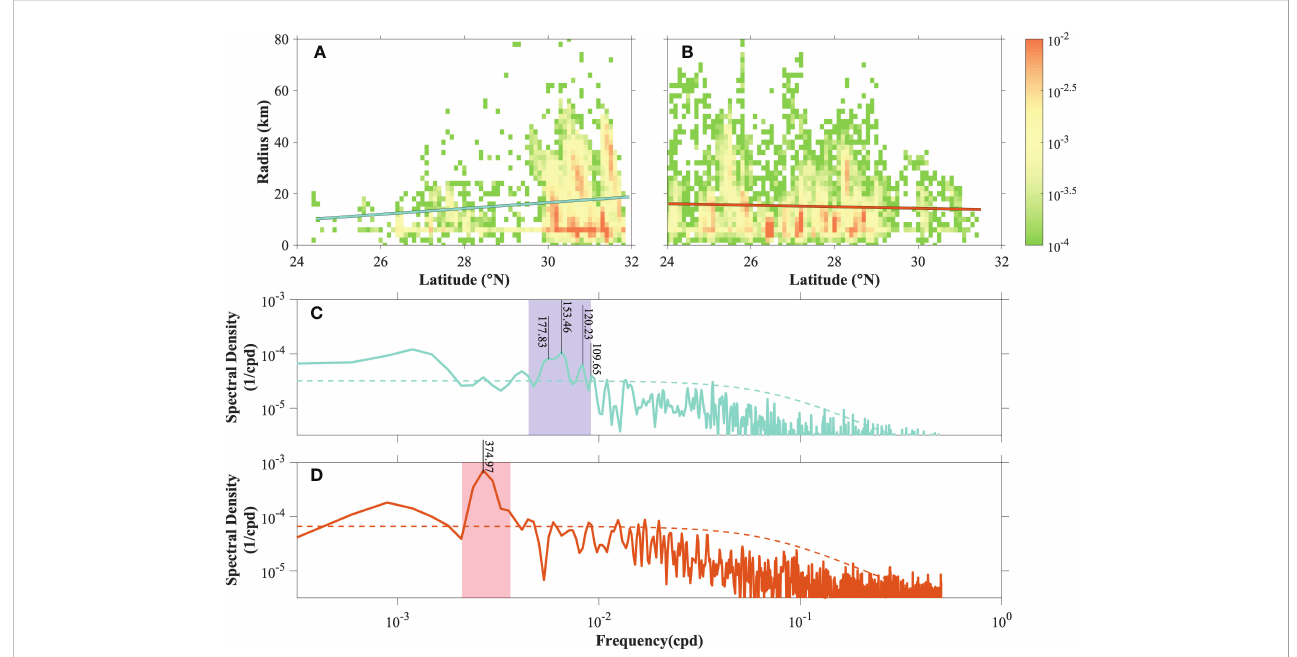
FIGURE 8 The probability density distribution of horizontal radii for eddies is classi fi ed into two groups: one on the (A) left and another on the (B) right sides of the mean Kuroshio axis along the fl ow direction. The cyan and orange lines were linearly fi tted trends of eddy radiuses for latitudes. Only those eddies with northeastward propagation were retained. The others were removed. Frequency spectra for existing numbers of eddies on the (C) left and (D) right sides of the mean Kuroshio axis along the fl ow direction. Dashed lines were 95% signi fi cance levels estimated by the red noise spectra. Typical spectral period ranges were marked using purple and pink shading, which represented ~109 – 224 days (i.e., ~10 − 2.35 – 10 − 2.04 cpd) in (C) and ~275 – 478 days (i.e., ~10 − 2.68 – 10 − 2.44 cpd) in (D) , respectively.